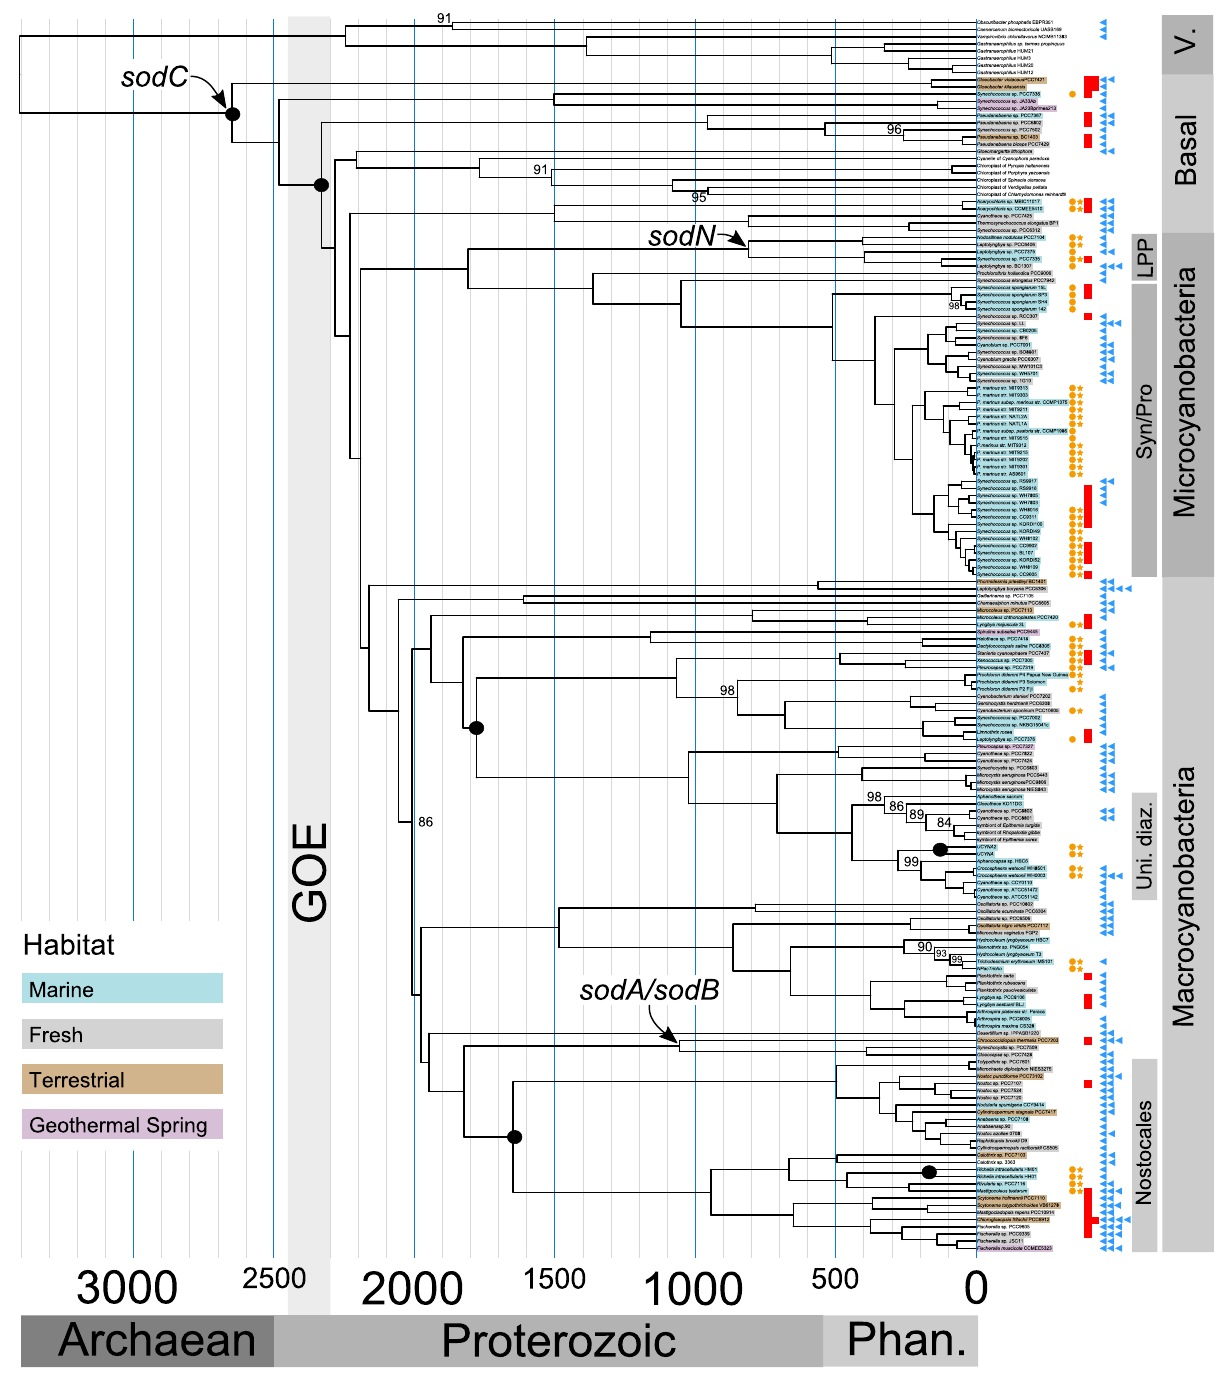
Fig. 3 Time-calibrated cyanobacterial tree of life and superoxide dismutases. Genes encoding NiSOD (orange circles), NiSOD maturation protease (orange stars), CuZnSOD (red squares), and SODs with Mn- or Fe- cofactors (blue triangles) are highlighted next to the strain names. The earliest node predicted to have sodN, sodC and sodA or sodB are annotated with labels (see Table 2 for posterior age probabilities and Supplementary Fig. 10 for the age distribution of these events). The phylogenetic tree was estimated from SSU and LSU ribosomal RNA and 136 core cyanobacterial proteins from 167 different taxa using the maximum likelihood methodology implemented in IQ-TREE v1.6.1 46 . Node labels represent ultrafast bootstrap approximations <100 98 . Ages were estimated using a Bayesian relaxed molecular clock with Uncorrelated Gamma Multipliers 49 for ribosomal RNA. Black circles represent calibration points (Table 1). The fi rst divergence of cyanobacteria was constrained to occur between 2.7 Ga and 2.32 Ga 110,111 . The color behind each strain name indicates whether it is from a marine habitat (light blue), freshwater habitat (gray), terrestrial habitat (light brown), or geothermal spring (light pink). GOE Great Oxidation Event, Uni. diaz. unicellular diazotrophs, Phan. Phanerozoic eon, V.